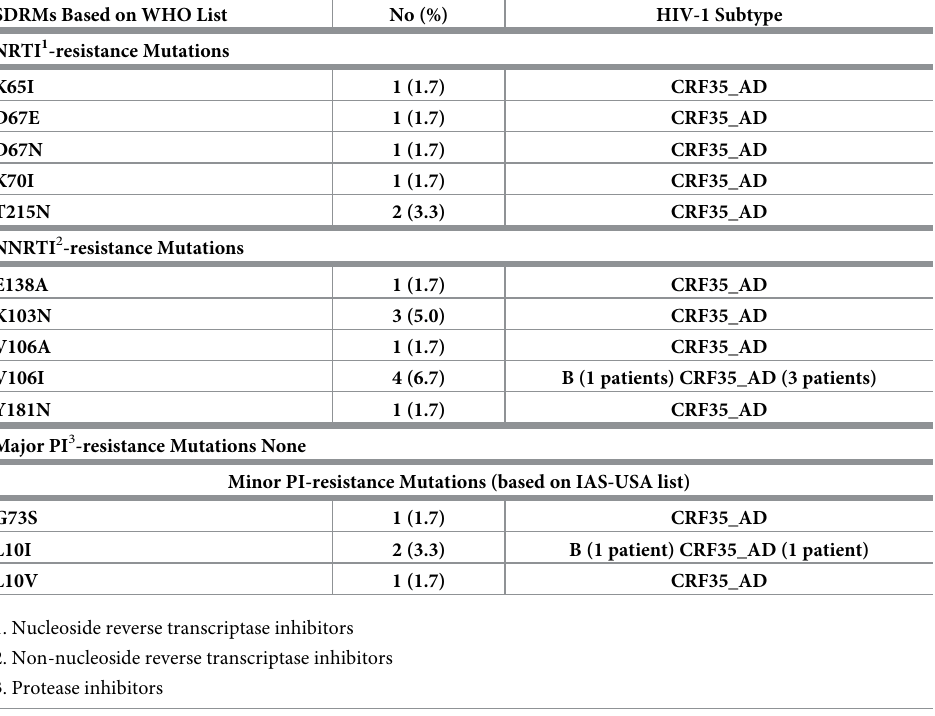
Table 4. Frequency of human immunodeficiency virus surveillance drug resistance mutations in treatment-na ï ve Iranian patients with HIV infection. SDRMs Based on WHO List No (%) HIV-1